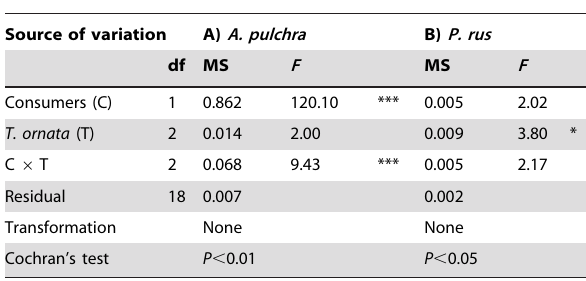
Table 2. ANOVA on the effects of Consumers (present versus excluded) and T. ornata (absence versus medium cover versus high cover) on the net growth of A) A. pulchra and B) P. rus